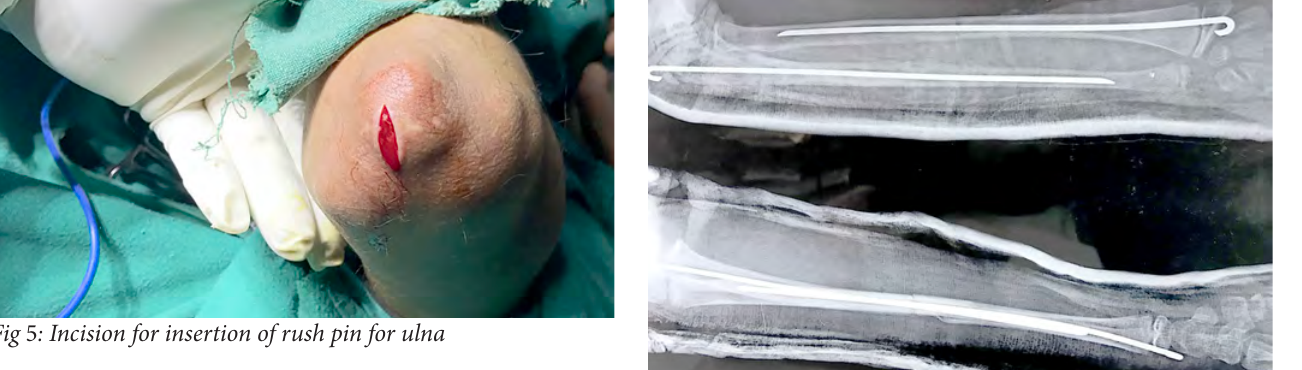
Fig 7 : Postoperative check X-ray